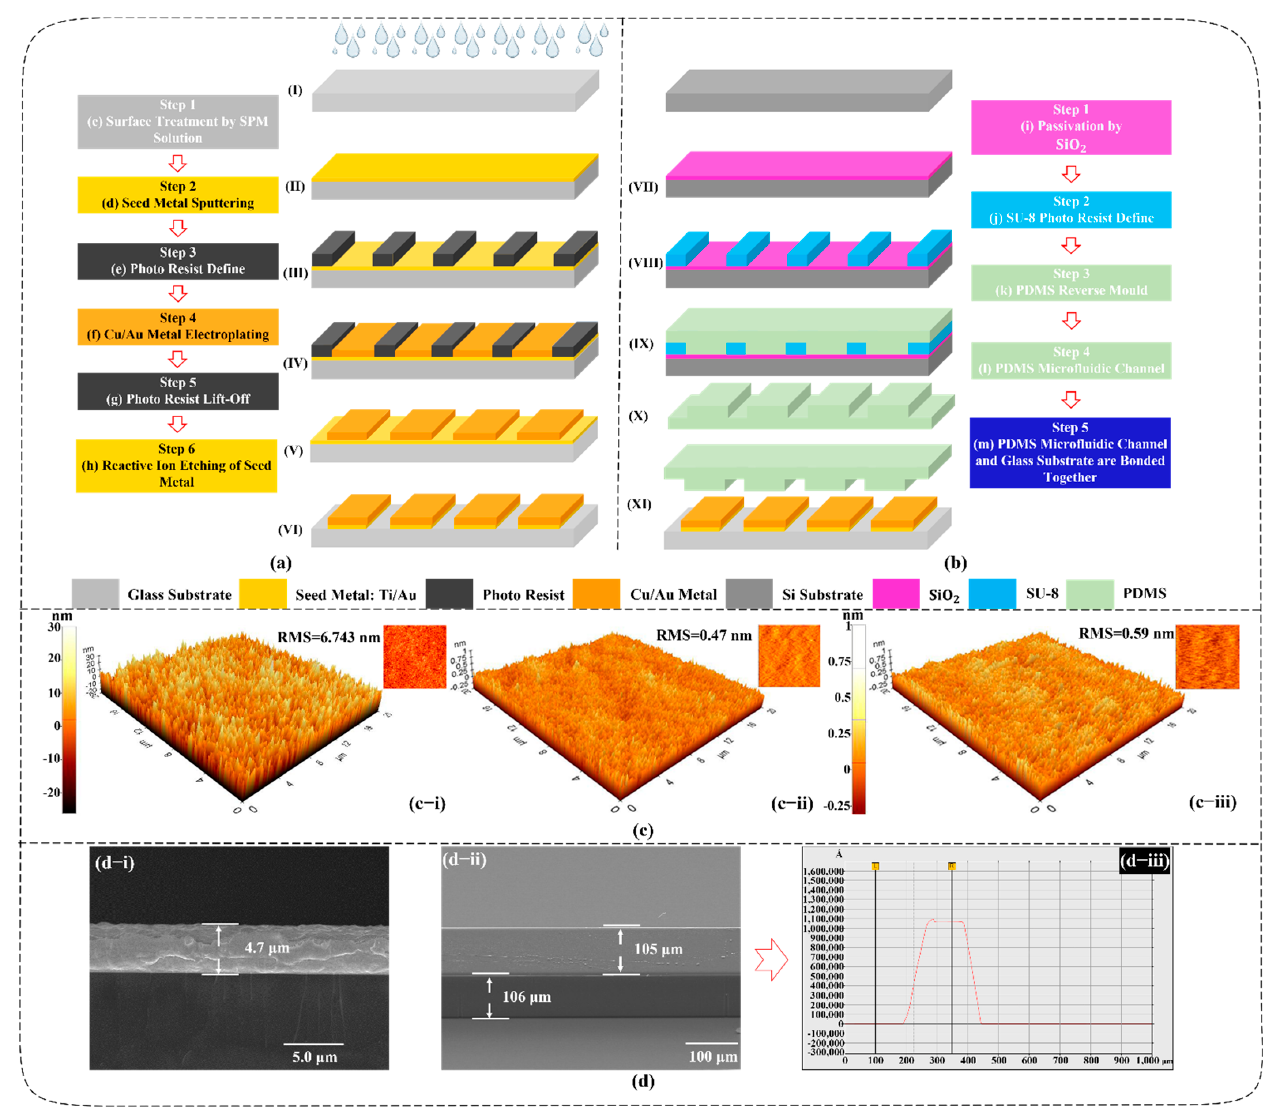
Figure 1. ( a ) Fabrication process of the metal structure for the resistor and capacitor; ( b ) fabrication process of the PDMS microfluidic channel; ( c ) morphological analysis; ( c − i ) surface profile of bare glass substrate; ( c − ii ) seed metal; ( c − iii ) seed metal after O 2 etching; ( d ) morphological analysis; ( d − i ) SEM image of metal on glass substrate; ( d − ii ) SU-8 line pattern on Si substrate; ( d − iii ) height and width measurements of the SU-8 line pattern.